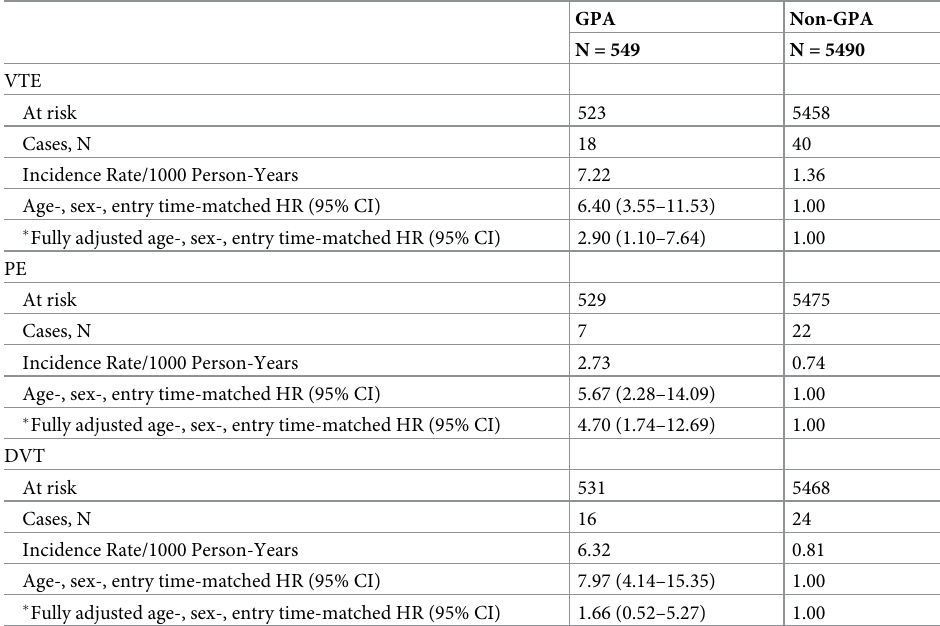
Table 2. Relative risk of incident PE and DVT according to GPA status.